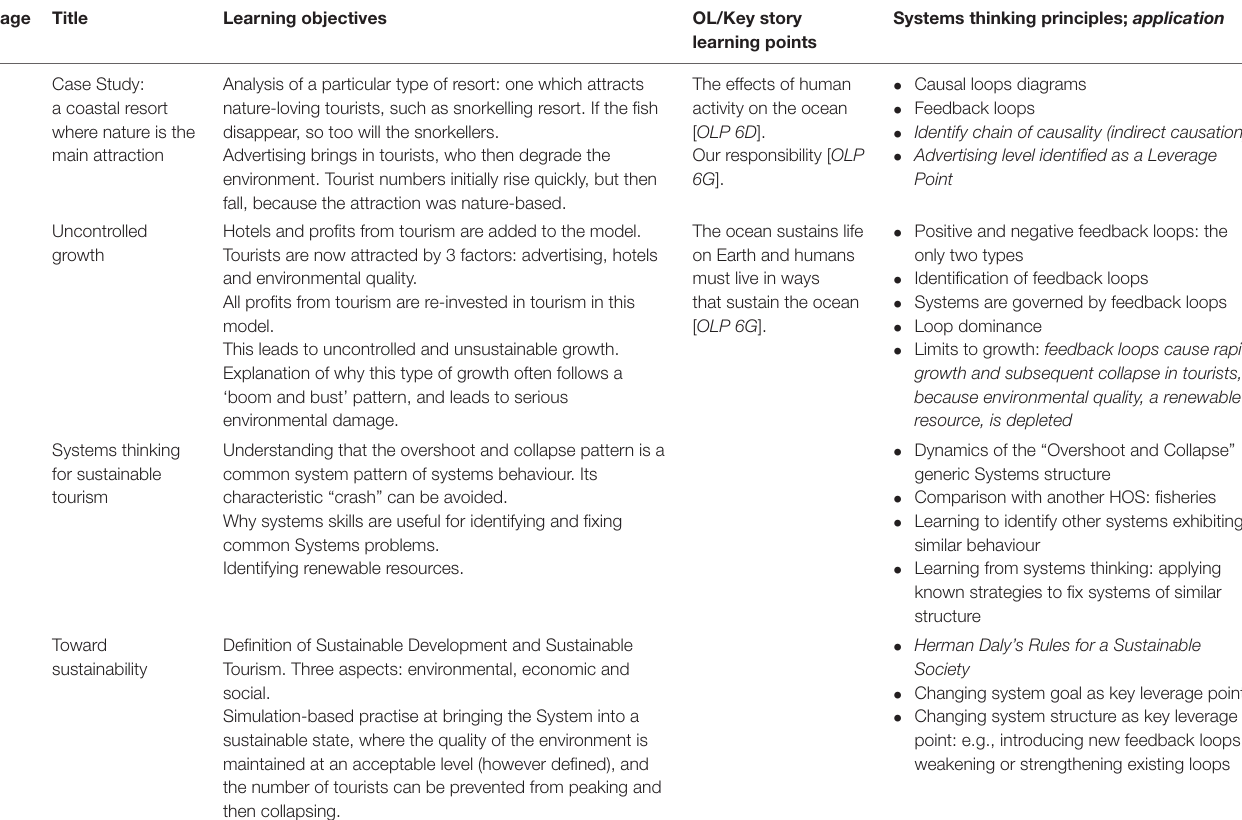
TABLE 2 | Ocean literacy and systems thinking learning objectives identified (part